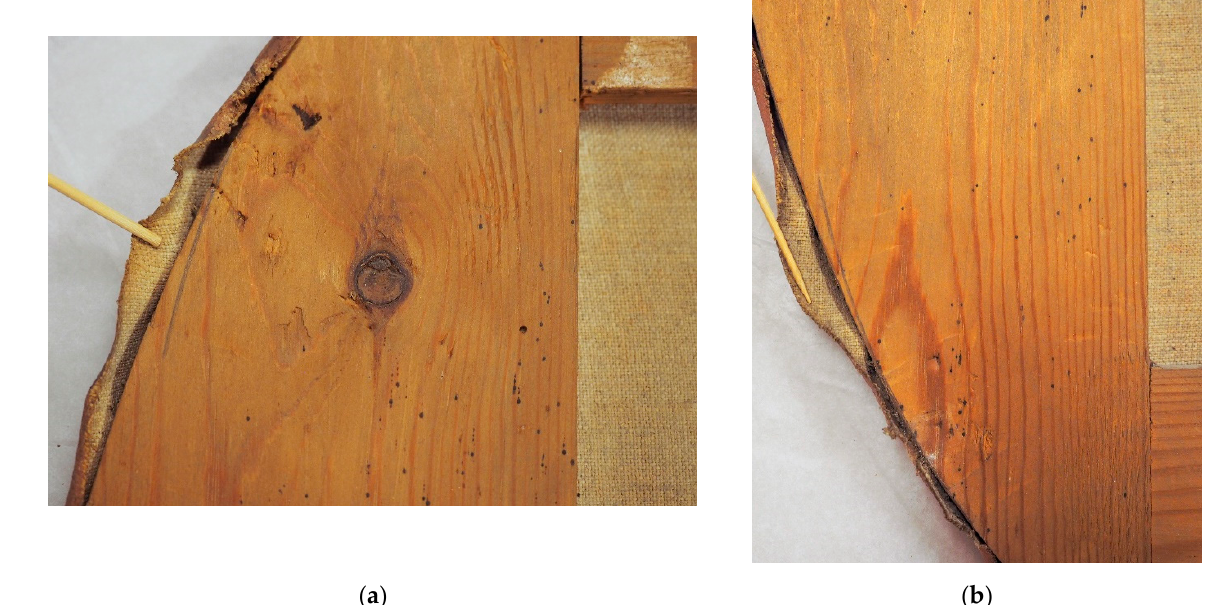
Figure 11. Pencil marks present both towards the top ( a ) and bottom ( b ), on the left bar of the strainer of E. Moltke (SV6), corresponding to a circular arched shape—in this case, the two minor circles of the oval.